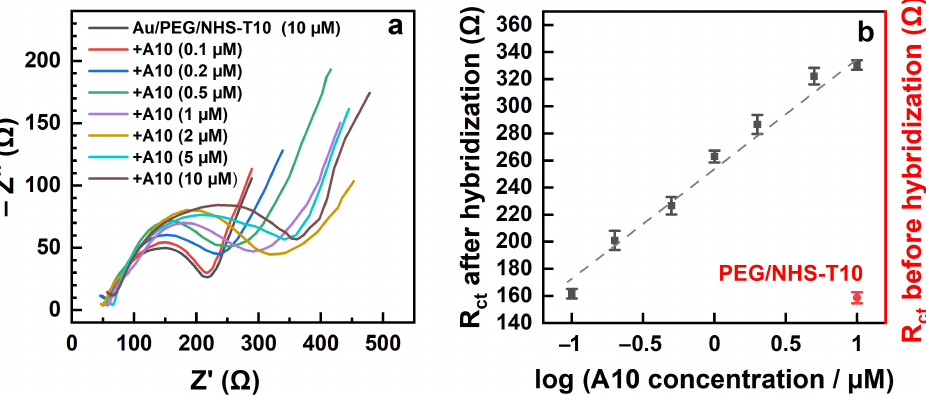
Figure 9. Nyquist plots ( a ) and the derived R ct values ( b ) for the Au/PEG/NHS-T10 working electrode before (red symbol in b ) and after (black symbols in b) its exposure to matching A10 target ssDNA. The concentration of A10 was varied. The R ct behavior in ( b ) is tentatively traced by straight dashed line.